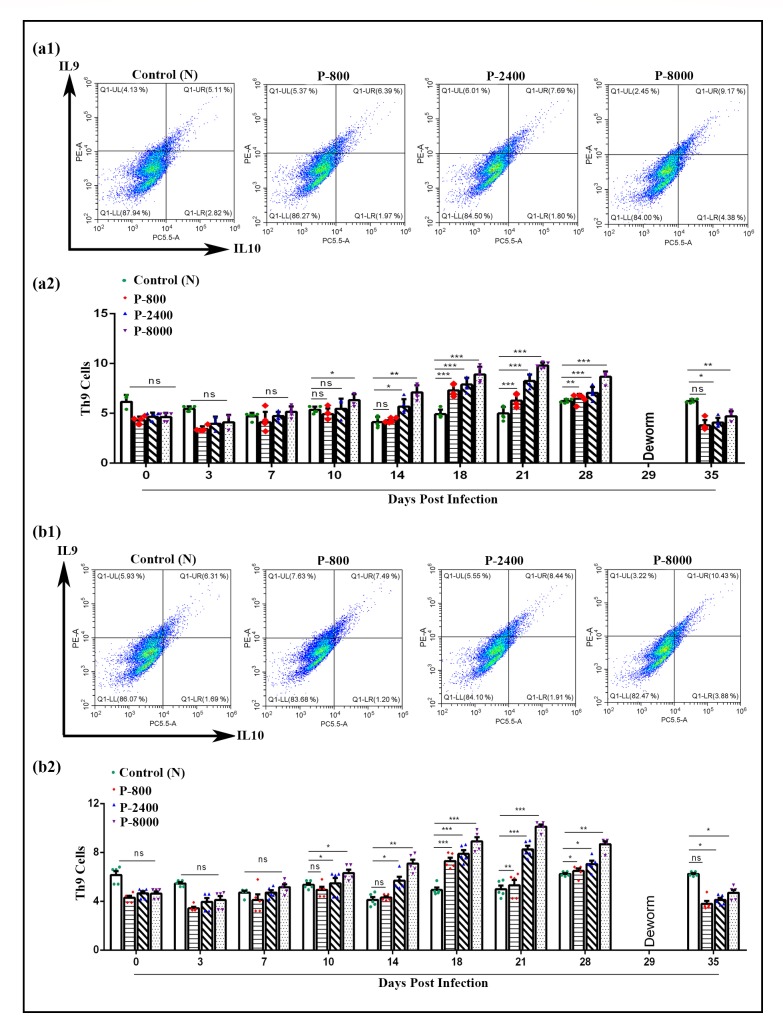
Dot plot analysis (gated on CD2+CD4+ T cells) and proportion of Th9 cells during different stages of H. contortus by flow cytometry using representative intracellular cytokine antibodies (IL-9 and IL-10).(a1): Dot plot analysis of trial 1; (a2): Th9 cells proportion of trial 1; (b1): Dot plot analysis of trial 2; (b2): Th9 cells proportion of trial 2. PBMCs derived-T helper-9 cells were collected from different groups of H. contortus infected dose rate. P-800: Goats (n = 10 each) infected with 800 H. contortus L3; P-2400: Goats infected with 2400 H. contortus L3; P-8000: Goats infected with 8000 H. contortus L3; 0–35: Days post-infection. The control group was kept untreated. Data are presented two experiment of the standard deviation (SD) and representative of triplicate experiments (*P < 0.05, **P < 0.01, ***P < 0.001).